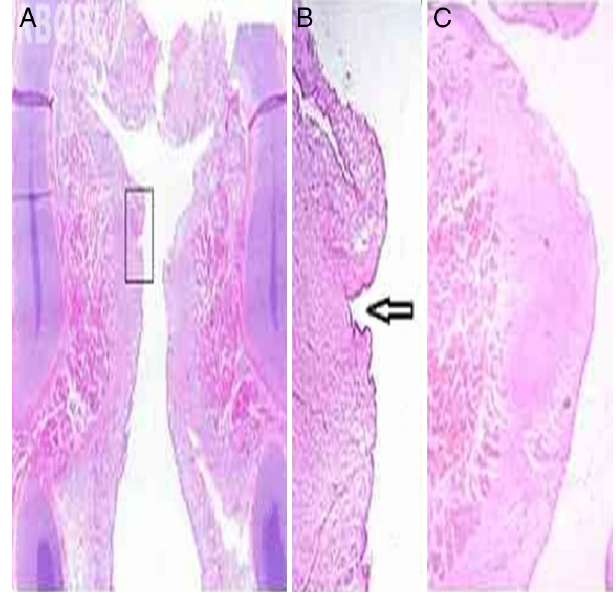
Figure 3 (A) Frontal histological section of larynx 9, HE stain- ing. In the detail, (B) left sulcus vocalis, indicated by the arrow (up to 20 × ). (C) Frontal histological section of left vocal fold without alterations, in larynx 2, which showed no alteration at the inspection and instrumental palpation examination, HE staining, 12 ×